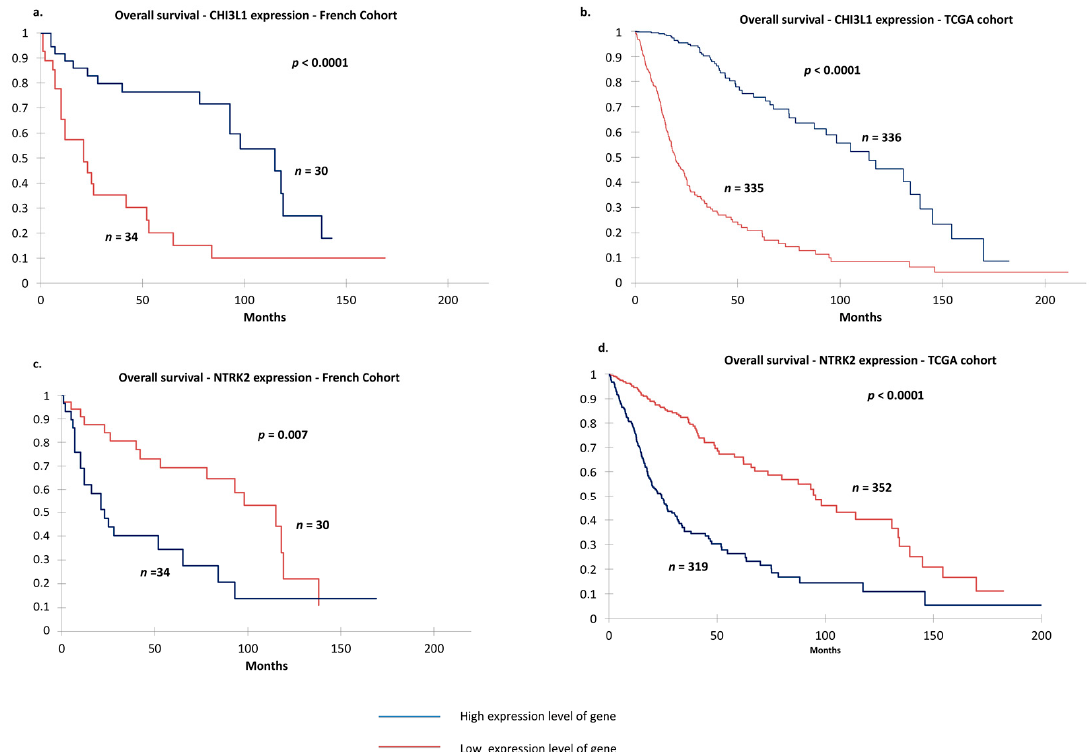
Figure 4. Overall survival according to di ff erential gene expression (median) by Kaplan–Meier analysis. Di ff erential expression of CHI3L1 in glioma from ( a ) our cohort and ( b ) TCGA cohort. Di ff erential expression of NTRK2 in glioma from ( c ) our cohort and ( d ) TCGA cohort. Red line represents high gene expression; blue line, low expression. p -values were calculated using log-rank test.